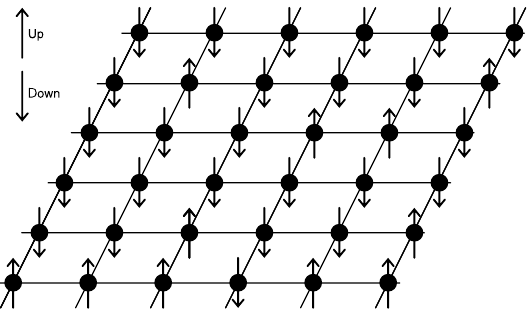
Figure 1. 2D Array Ising